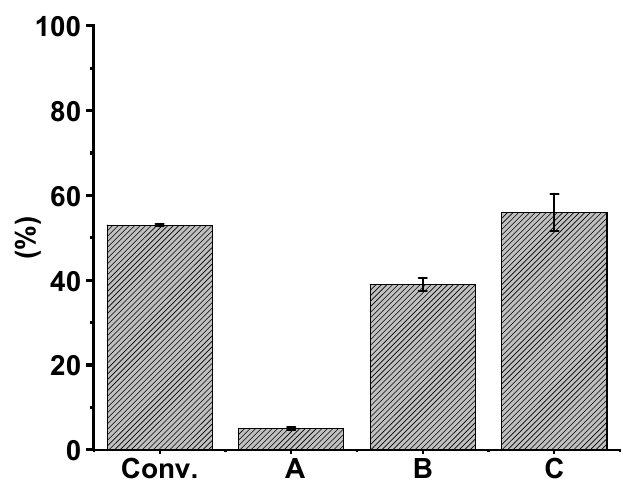
Figure 4. Conversion of cyclohexene (%) and product selectivity (%) (A = 1,2-epoxycyclohexane; B =